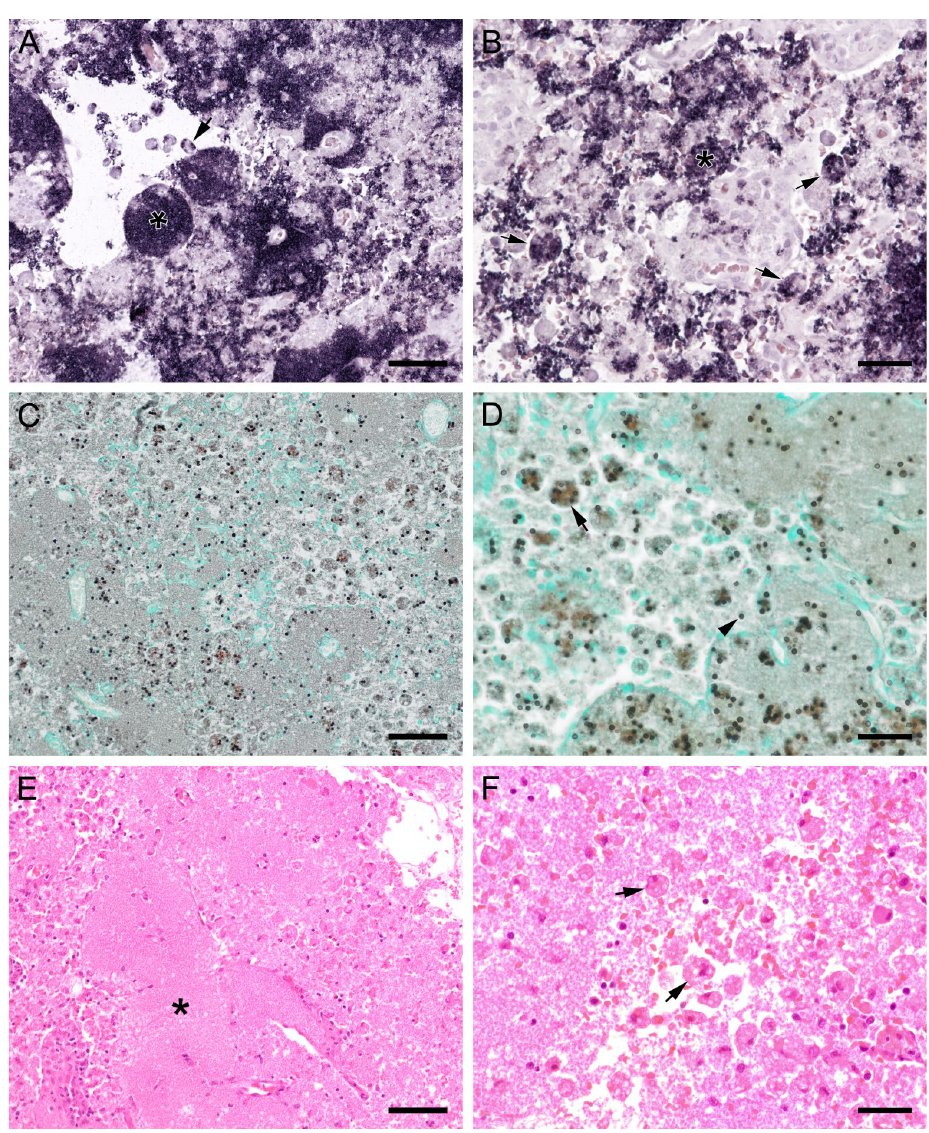
Figure 10. Sections from the lung of a dog with severe PCP. ( A , B ) Large areas with numerous developmental stages are labeled by ISH. Signals are present free (asterisks) and within cells with the morphology of alveolar macrophages (arrows). ( A ) Bar = 80 µ m; ( B ) Bar = 40 µ m; ( C ) GMS labels only cystic stages black. Trophozoites largely remain unstained. Bar = 80 µ m; ( D ) Asci are present free (arrowhead) and phagocytized within cells with the morphology of alveolar macrophages (arrow). Bar = 40 µ m; ( E ) Severely distended alveolar spaces are diffusely filled with myriads of eosinophilic, foamy, or spherical structures (asterisk). Bar = 80 µ m; ( F ) Variably sized cells with the morphology of macrophages containing Pneumocystis organisms (arrows). Bar = 40 µ